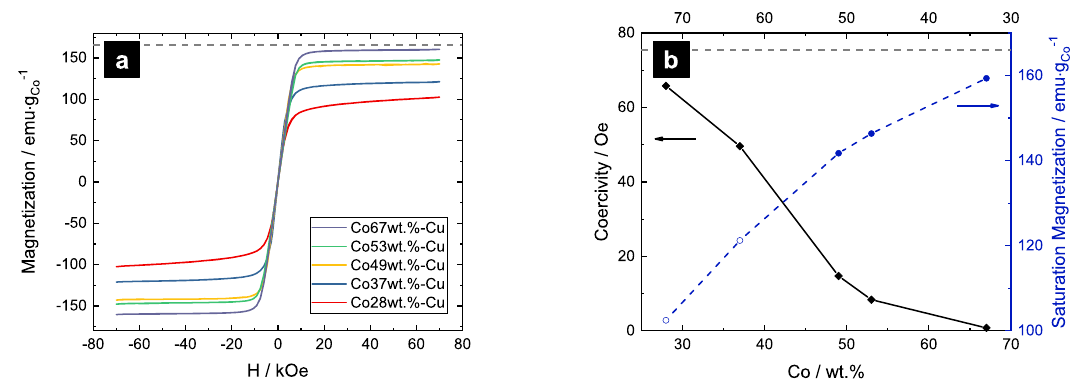
Figure 5. ( a ) magnetization versus applied field for Co-Cu samples measured at 300 K; ( b ) coercivity and saturation magnetization are plotted versus Co-content. The grey dotted lines in both figures indicate the magnetic moment of fcc-Co (166 emu · g − 1 ). Full saturation is not achieved for Co contents ≤ 40 wt.% in a field of 70 kOe (open symbols in ( b